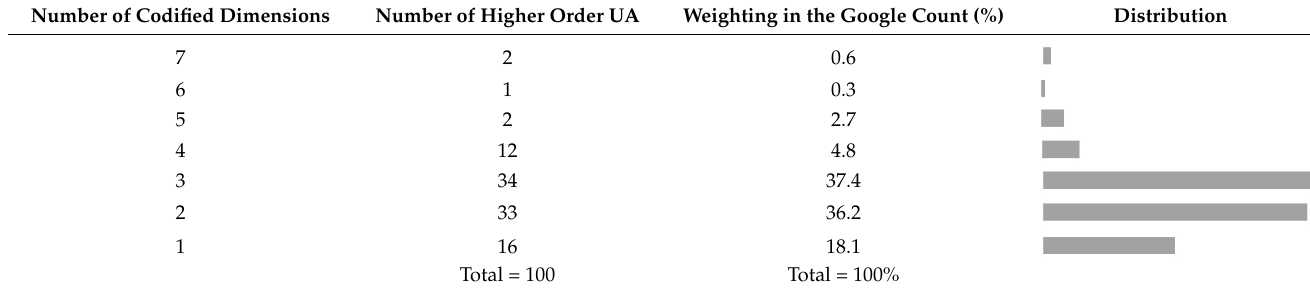
Table 3. Number of higher order UA.